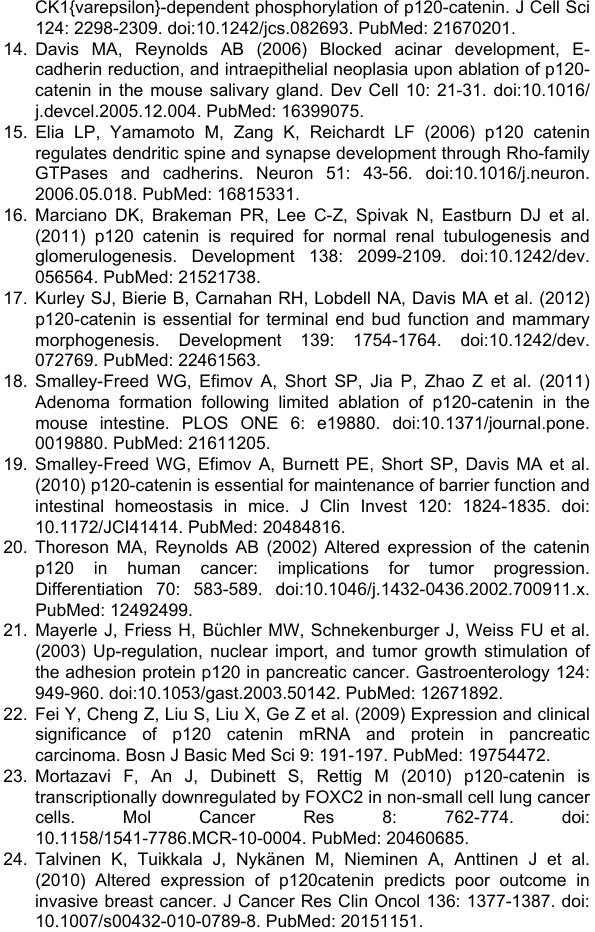
Figure S1. p120ctn mutants are not sensitive to oxidative or salt stress. (A-B) Survival of w 1118 and w 1118 ; p120 308 males and females treated with 20uM Paraquat. Data are plotted as adult survival in hours. (C-D) Survival of w 1118 and w 1118 ; p120 308 males and females treated with 1% H 0 . Data is plotted as 2 2 adult survival in hours. (E-F) Survival of w 1118 and w 1118 ; p120 308 males and females treated with 6% NaCl. Data is plotted as adult survival in hours. Blue lines indicate w 1118 controls and red lines w 1118 ; p120 308 . Each curve represents 100 flies. Median survival is presented for each cohort and p value generated using log-rank tests.